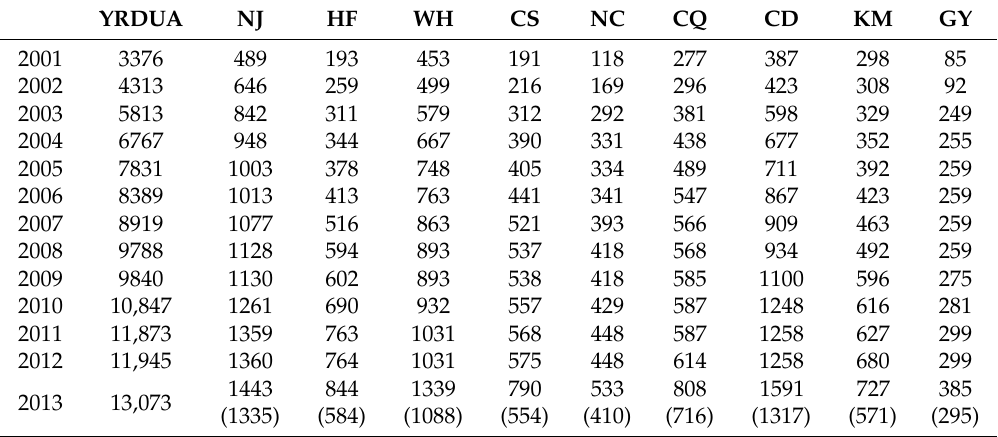
Figure 3. The comparison of different data and methods of extracting the urban areas or water body in WH: ( a ) urban areas in WH extracted from MODIS LCD in 2001; ( b ) urban areas in WH extracted from MODIS LCD in 2013; ( c ) urban areas in WH extracted from stable nighttime light data in 2013; ( d ) the union areas of water body in WH extracted from MODIS LCD; ( e ) SNLD and MODIS LCD were combined to produce the urban areas in WH. The background map was the land surface temperature (LST, °C) in WH in summer, 2013. Table 2. The amount of urban area in the 10 cities for the year 2001 and 2013. Unit: square kilometer. The numbers in parentheses indicate the area extracted from Landsat data.